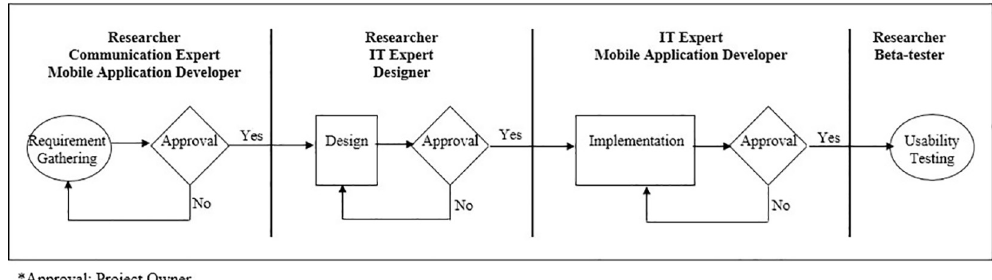
Fig 7. Development and usability testing responsibilities and process flow diagram.